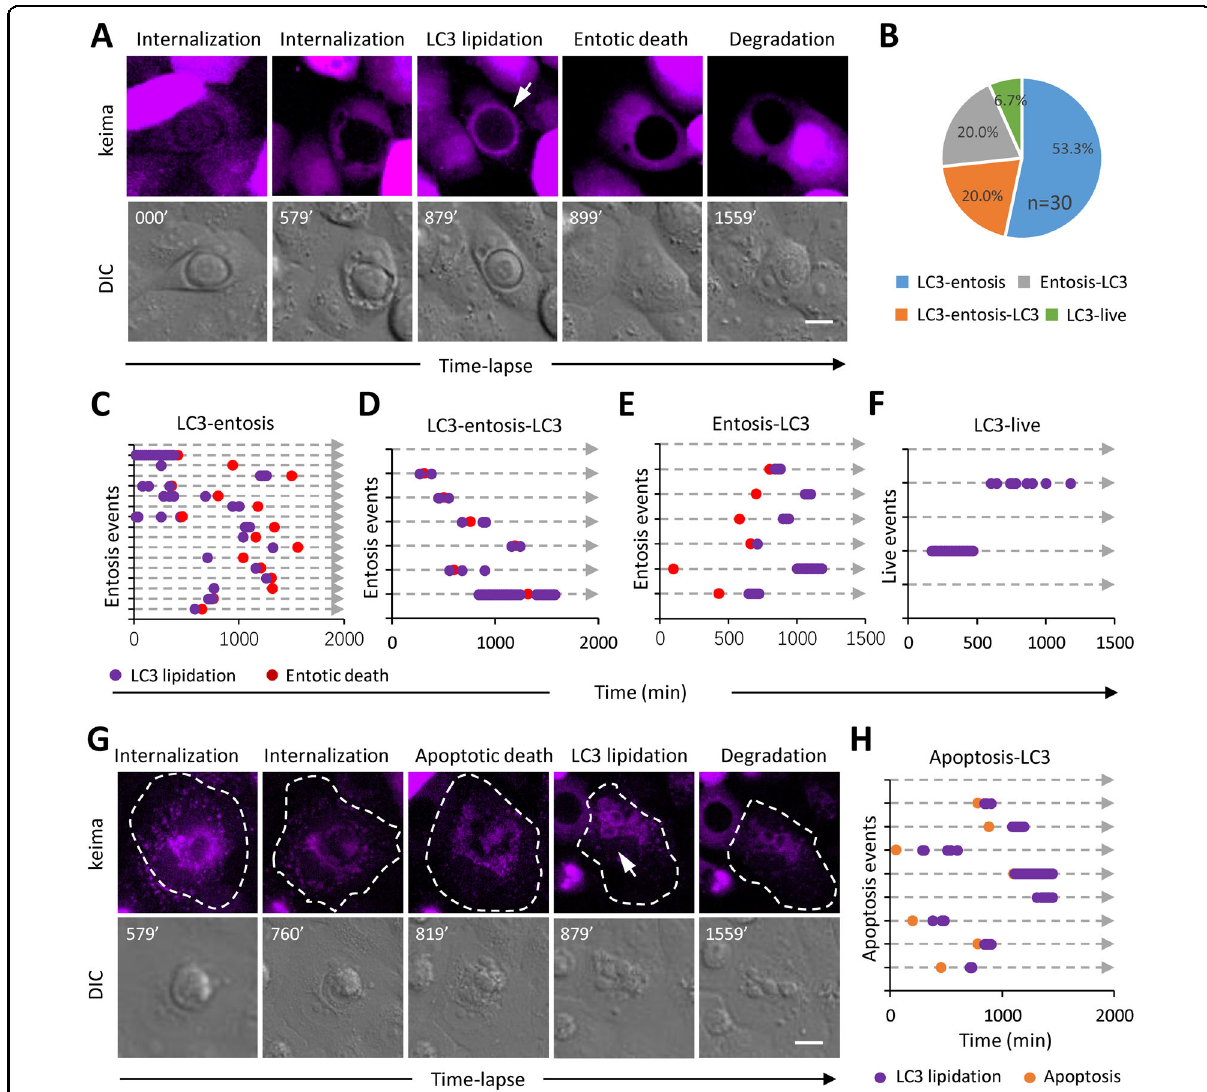
Fig. 3 The dynamics of vacuolar LC3 lipidation. A Time-lapse images of transient recruitment of GFP-LC3 (purple) to the entotic vacuole prior to inner cell death. Arrow indicates LC3 on the entotic vacuole, also see Supplementary Information Movie S3. Scale bar, 10 µm. B Pie chart shows the percentage of four types of LC3 lipidation as indicated, n = 30. Time course-based plotting of four patterns of LC3 recruitment (purple dots) in related with the fates of internalized cells, including LC3 lipidation before entotic death ( C ), LC3 lipidation before and after entotic death ( D ), LC3 lipidation after entotic death ( E ), LC3 lipidation for live inner cells ( F ). G Time-lapse images of vacuolar GFP-LC3 (purple) recruitment following inner cell apoptosis. Arrow indicates LC3 recruited to the apoptotic body, also see Supplementary Information Movie S4. Scale bar, 10 µm. H Time course-based plotting of LC3 lipidation in related with inner cell